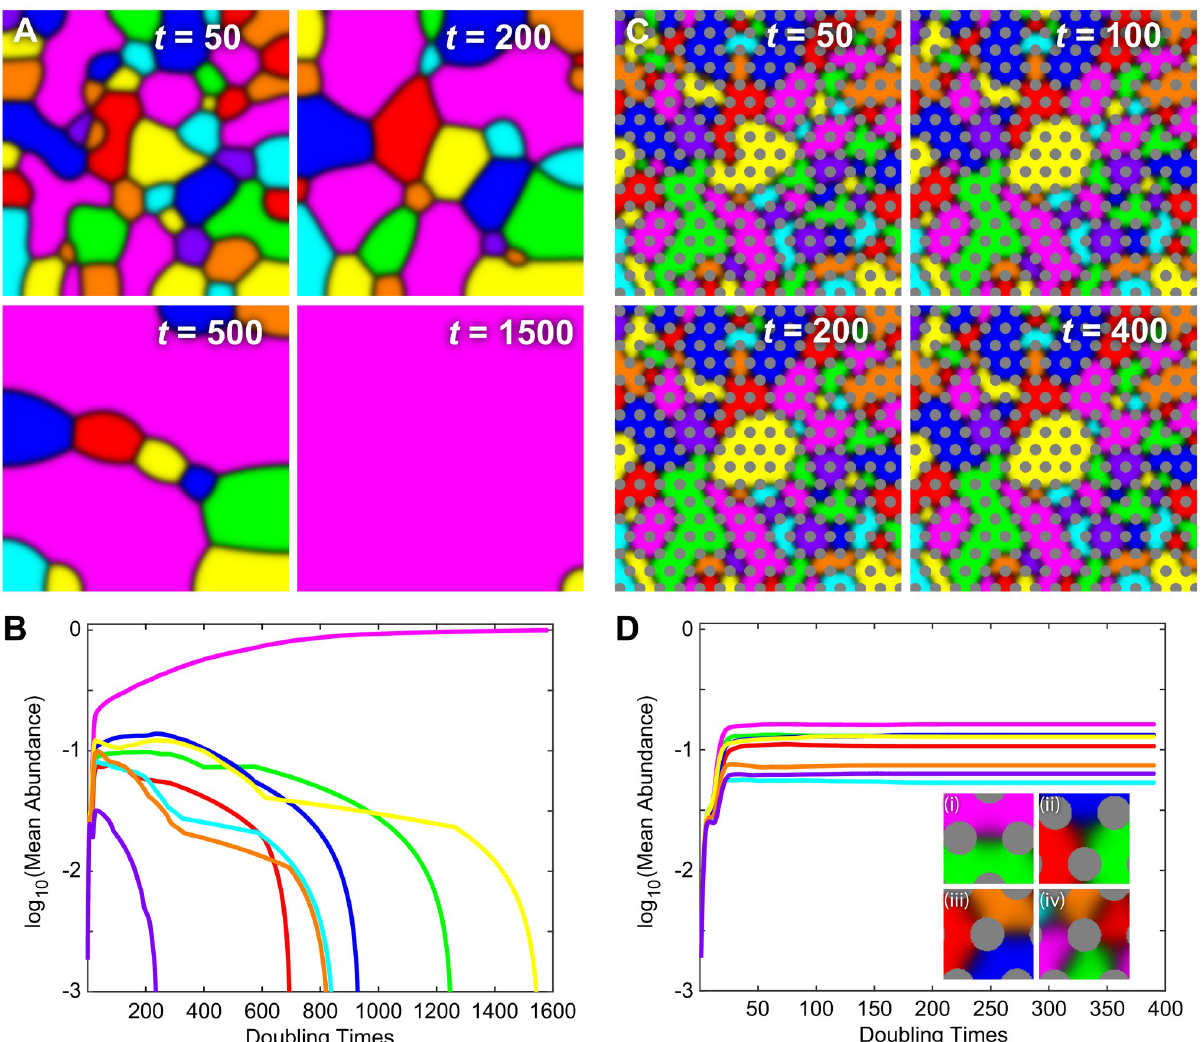
Fig 1. Steric structures stabilize an in silico multi-species ecosystem. Shown here are two 8-species in silico ecosystems in which all species are actively competing with all other species and the competition parameters are equal for all pairwise interactions. (A & B) Simulation of competition in an isotropic environment. If initial species representation is statistically equal, each species has equal probability of dominating the environment in the long-time limit. However, in any single simulation the dynamics of interspecies boundaries lead to a single dominant competitor in the long-time limit. (C & D) When species compete in an environment with ordered steric structures ( R = 3, Δ x / R = 3.5, and δ = 0), interspecies boundaries that are mobile under isotropic conditions quickly ‘pin’ between steric objects and arrest the genetic-phase coarsening that leads to a single dominant competitor, thereby robustly producing stable representation of all species. Steric structures also permit situations where 3 or more species form a ‘junction’ around a steric object (Diii and Div). In both simulations L = 150, h P i = 0.25, and Δ P =